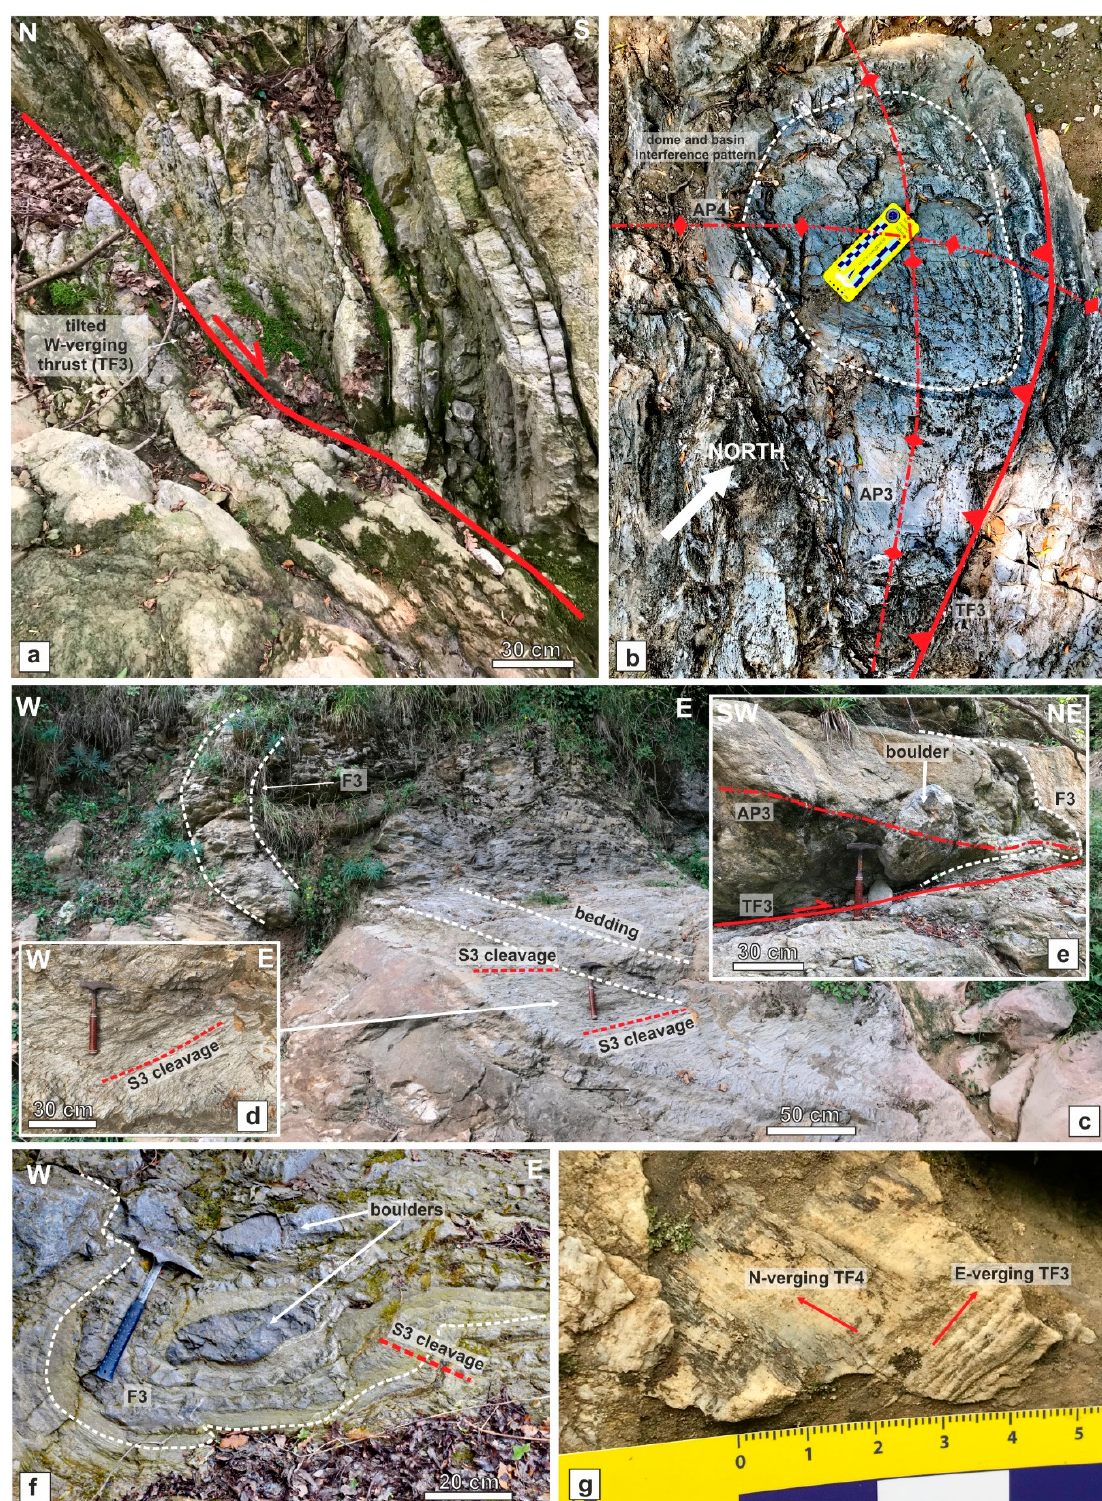
Figure 6. Campagna tectonic window (Salitto). Mt Croce unit: ( a ) W-verging thrust (TF3) subsequently tilted by an N–S shortening (D4 stage). ( b ) Dome-and-basin interference pattern between the two orthogonal folding events related to the D3 and D4 stages; ( c ) macro-scale overturned fold in the marls and sandstones; ( d ) fold axial plane cleavage associated with the macro-scale fold. CVTG: ( e ) minor thrust fault and hanging wall anticline in the CVTG. ( f ) Minor fold in the CVTG conglomerate; ( g ) two orthogonal sets of slickenside fibers along the same thrust plane.